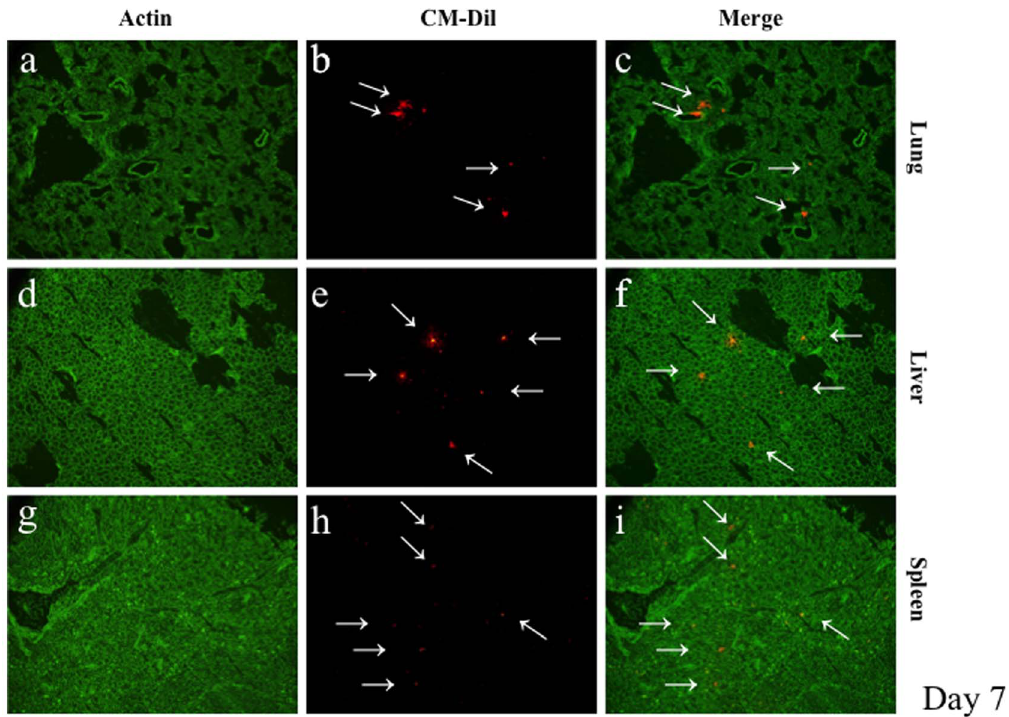
Figure 8. Detection of CM-DiI-labeled MSCs in lungs, liver, and spleen. Representative pictures of frozen tissue sections of lungs, liver, and spleen of an MSC-treated rat at 5 h after CM-DiI-labeled hMSC administration. The presence of CM-DiI-labeled hMSCs (red stained cells; arrows) was examined by counterstaining with actin antibody (green staining). Original magnifications, x200 (a–f).